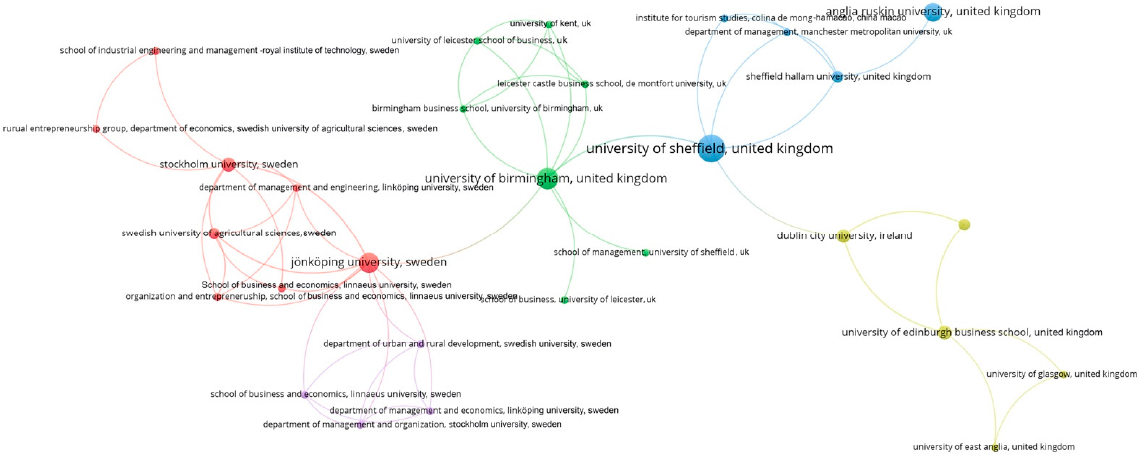
Figure 10. Organizations co-occurrence map